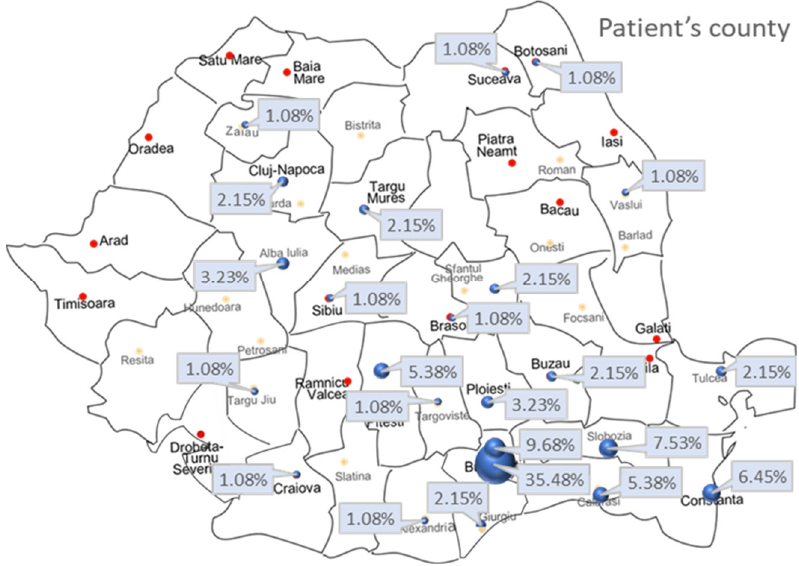
Figure 3. Geographical distribution of